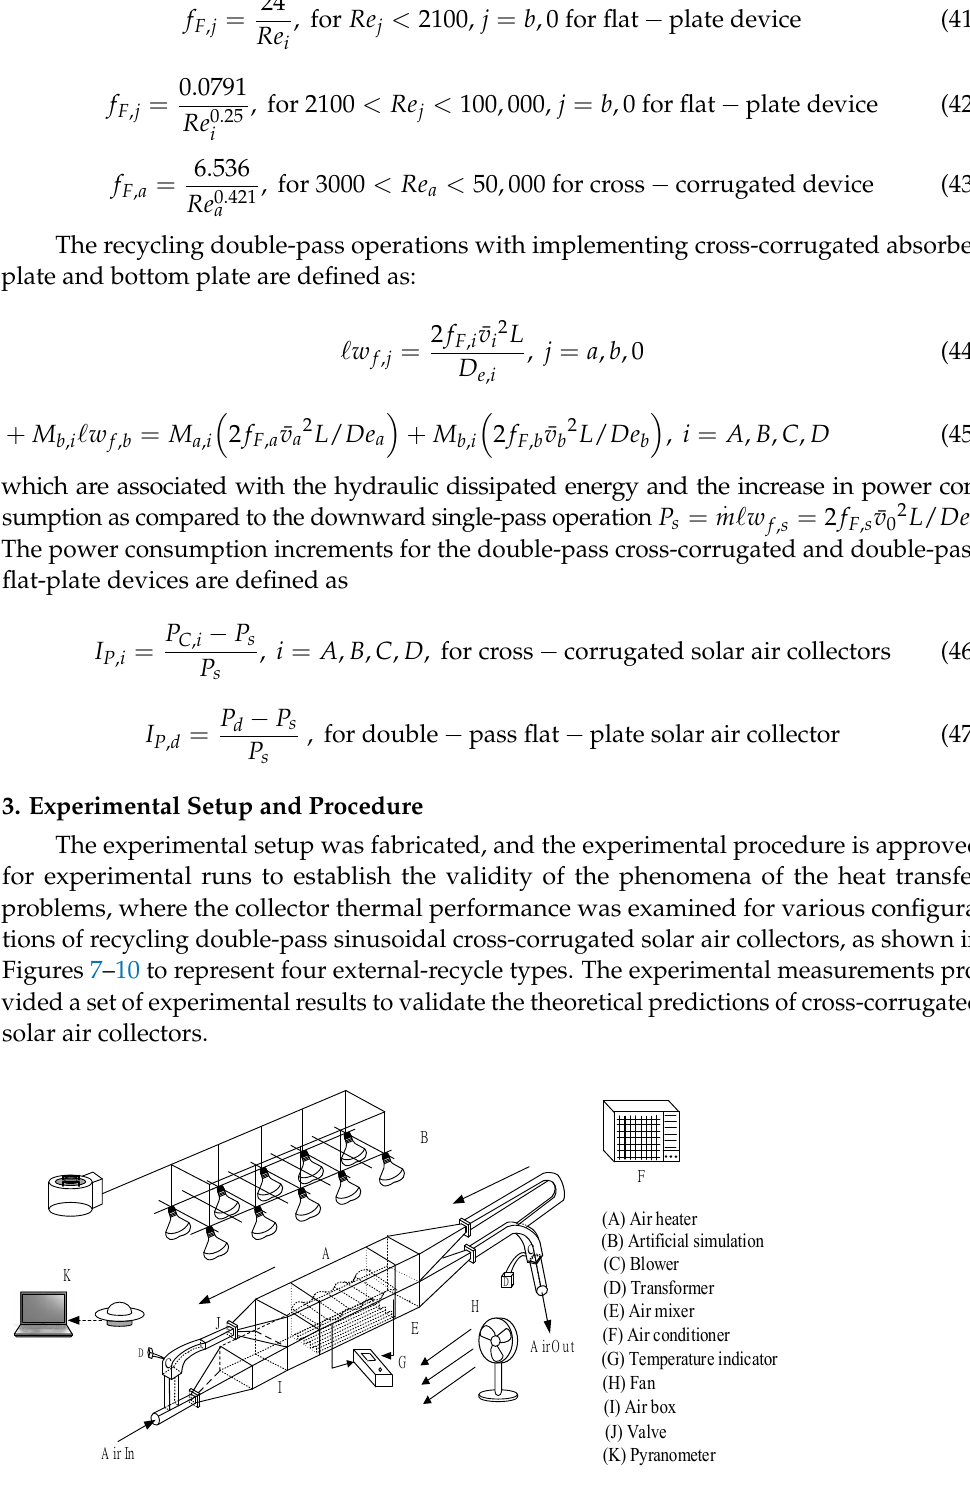
K Figure 8. Experimental setup of a recycling cross-corrugated solar air collector ( Type B ). c